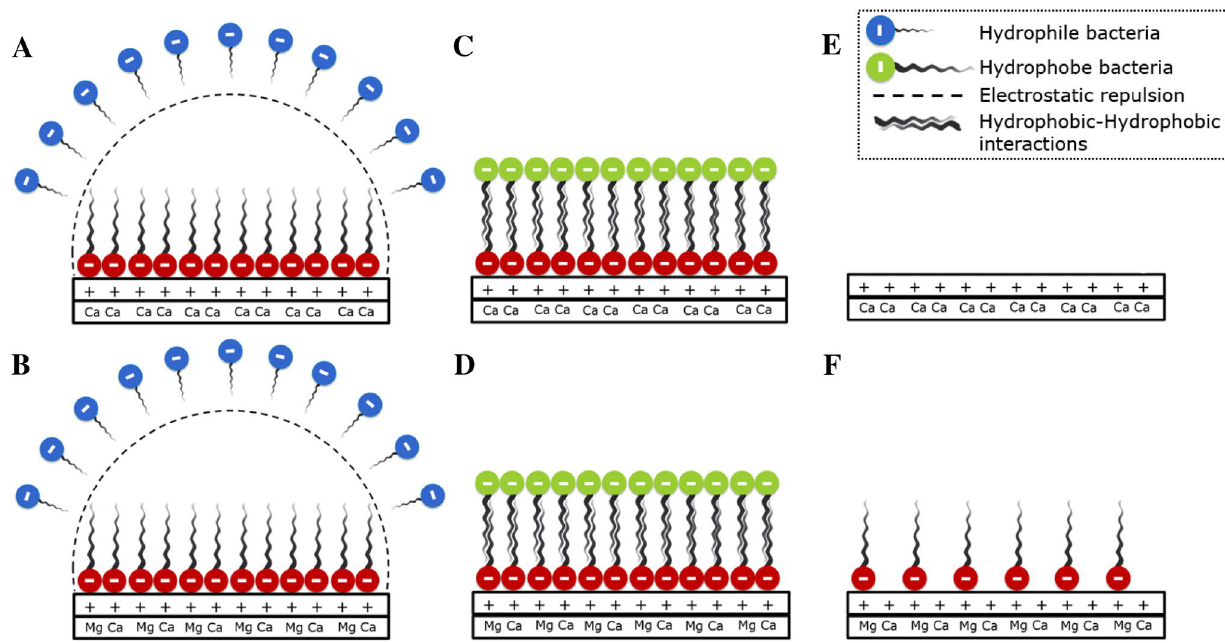
Fig. 4 Different bacteria cells effect on the wettability of oil-wet calcite and dolomite surfaces; electrostatic repulsion between nega- tive charged bacteria and the oil-wet a calcite and b dolomite sur- faces does not allow bacteria to reach the organic matter. In the case of hydrophobic strains, hydrophobic–hydrophobic interactions help bacteria cells to pass the steric hindrance and get access to